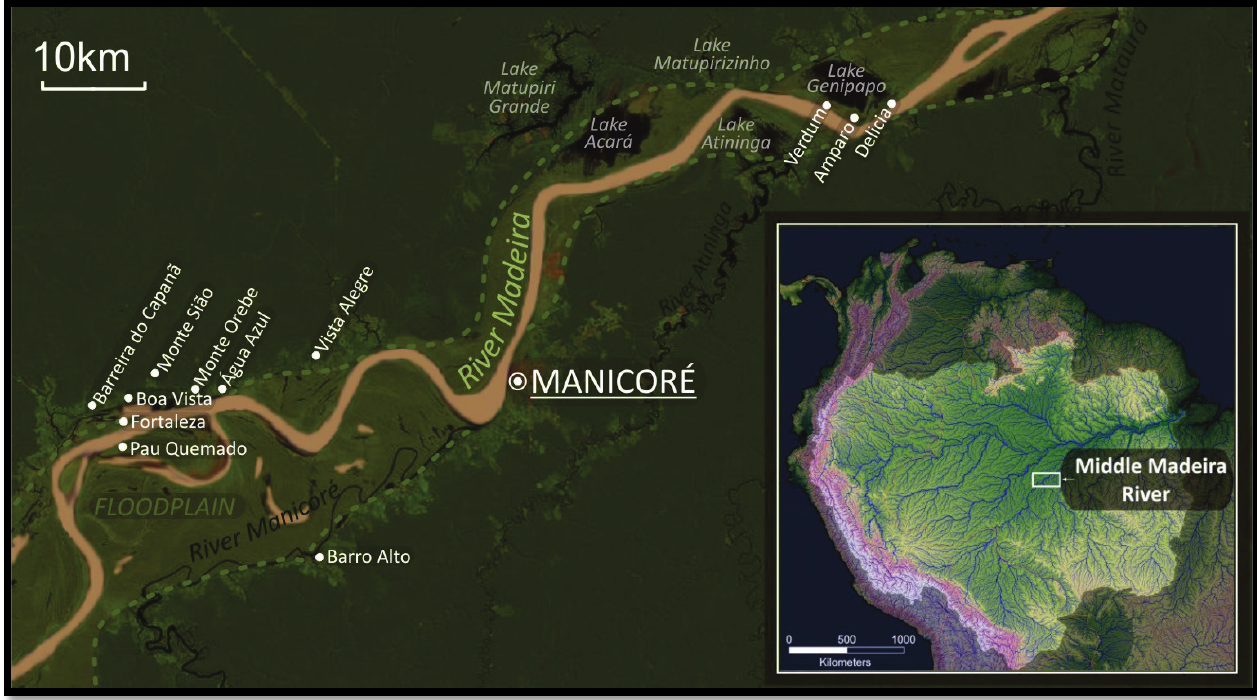
Figure 1. Map of the middle Madeira River, Amazonas, Brazil with the locations of the 12 communities where quantitative data on manioc cultivation was gathered. The location of the middle Madeira River in wider Amazonia is inset in the bottom right hand corner. Map drawn by Victoria Frausin.